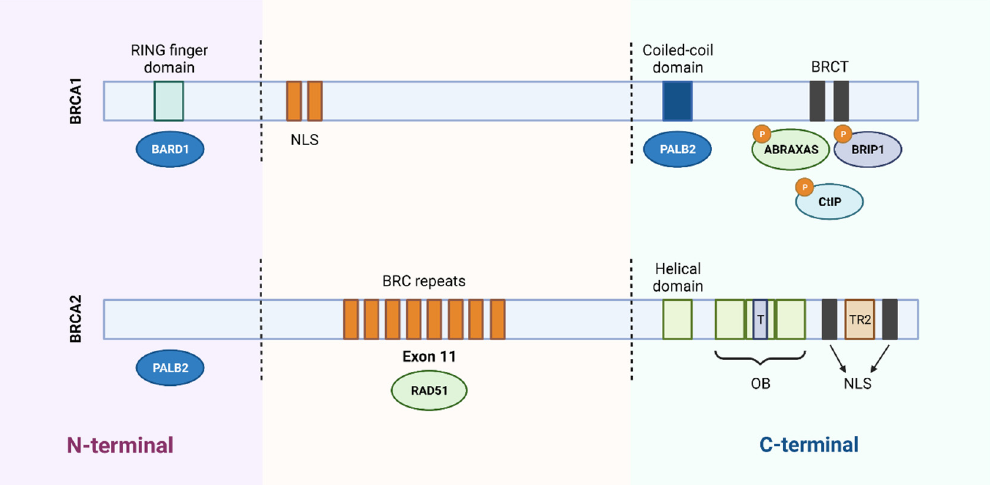
Figure 2. Schematic representation of the functional domains of BRCA1 and BRCA2 proteins. BRCA1 protein consists of 1863 amino acids and BRCA2 protein of 3418 amino acids. The N-terminal region of BRCA1 contains a RING domain that associates with the BARD1 protein. The central region of the protein contains two nuclear localization signals (NLS) and the C-terminal of BRCA1 contains a coiled-coil domain that associates with PALB2 and two BRCT domains that mediate interaction with different proteins. Regarding BRCA2, it binds to PALB2 through the N-terminal region and contains 8 BRC repeats, in the central region, responsible for its association with the RAD51 protein. In the C-terminal region, it contains a DNA-binding domain, consisting of a helical domain, a tower domain (T) and three oligonucleotide binding (OB) domains, which facilitates the binding of BRCA2 to DNA lesions. Furthermore, the carboxy terminal contains two NLS domains and a TR2 domain. Created with BioRender.com.